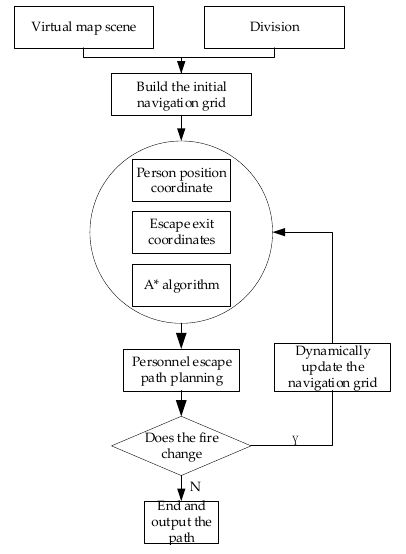
Figure 15. Dynamic navigation grid update process.